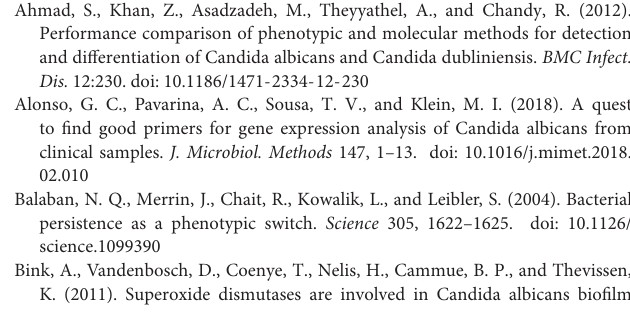
Supplementary Figure 1 | The Mean of 2 − (cid:49) ct − of CAT1, BCR1, and EFG1 genes in persister and non-persister isolates in inducing and promoting conditions ( t -test, * P -value < 0.05, ** P -value < 0.01). Supplementary Table 1 | Demographic information of HIV patients with and without persister cells. a The test was performed after pooling the last two groups (Elementary education, Higher education) in order to eliminate small expected frequencies (Fisher’s exact test, P -value < 0.05). Supplementary Table 2 | Quantitative information about HIV patients in the two groups of persister and non-persister cell. Data are median (IQR) or Mean ± SD. ∗ P -value < 0.05, ( t -test and Mann–Whitney test). Supplementary Table 3 | Information about patients undergoing chemotherapy in the two groups of persister and non-persister cells. Data are median (IQR) or Mean ± SD ( t -test and Mann–Whitney test), P -value <